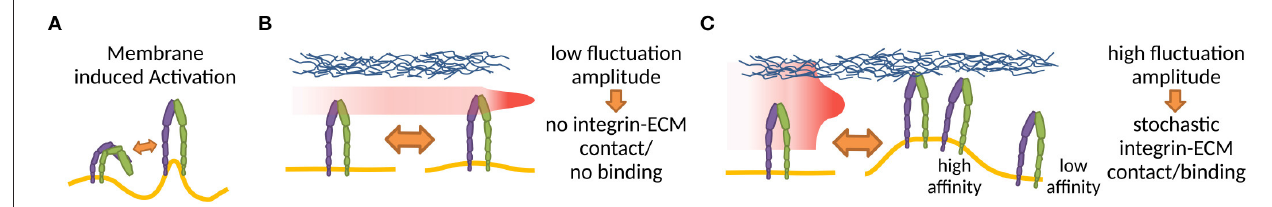
FIGURE 3 | (A) Membrane deformations, for example through curvature or thickness changes, can disrupt integrin TMD interactions, increasing fluctuation induced affinity modulation (Gingras and Ginsberg, 2020). (B,C) The amount of interaction of an integrin with a ligand presenting counterpart effectively alters the integrin binding affinity (Schmidt et al., 2012; Fenz et al., 2017) in a membrane fluctuation and therefore also glycocalyx dependent manner. The red area in (B,C) shows the positional distribution of the integrin head as a result of membrane fluctuations. The small fluctuations in (B) result in no integrin-ECM contact, whereas the high fluctuations in (C) result in stochastic integrin-ECM contacts, allowing stochastic binding and creating high affinity regions around the initial